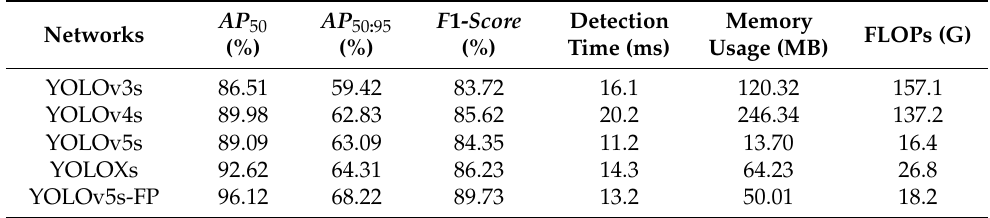
Table 3. Accuracy, detection time, and computational cost of the YOLOv5s-FP and typical networks of the YOLO